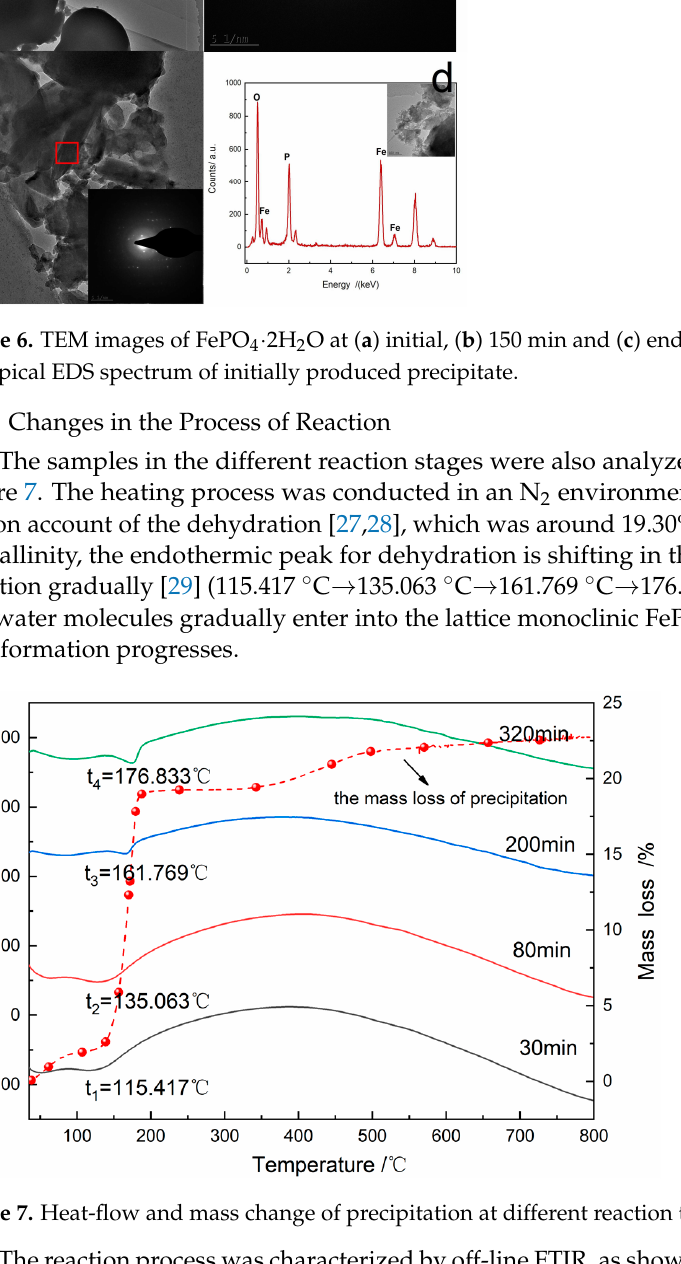
Figure 5. SEM images of morphology evolvement of FePO 4 ·2H 2 O during the experiment: ( a ) 0 min; ( b ) 30 min; ( c ) 150 min; ( d ) 450 min; ( a’ – d’ ) are images with the higher magnification at the corre- sponding times (0 min, 30 min, 150 min, 450 min).